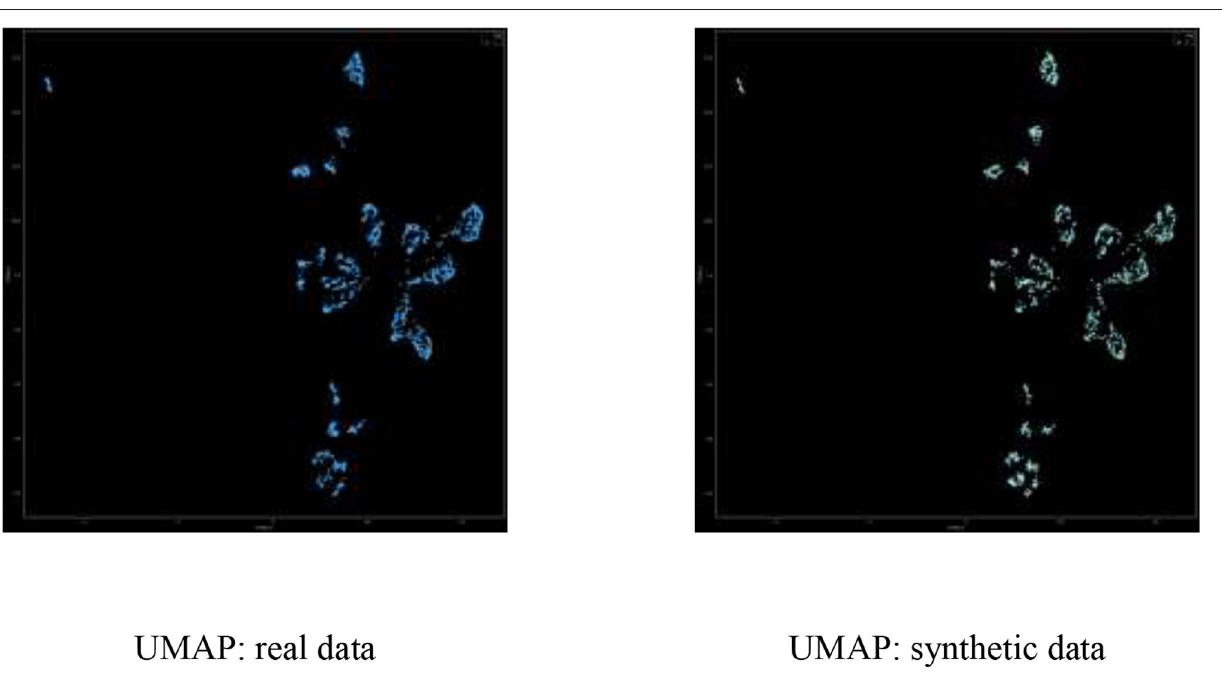
FIGURE 5 | UMAP visualization of real (left) vs. synthetic (right) data points in